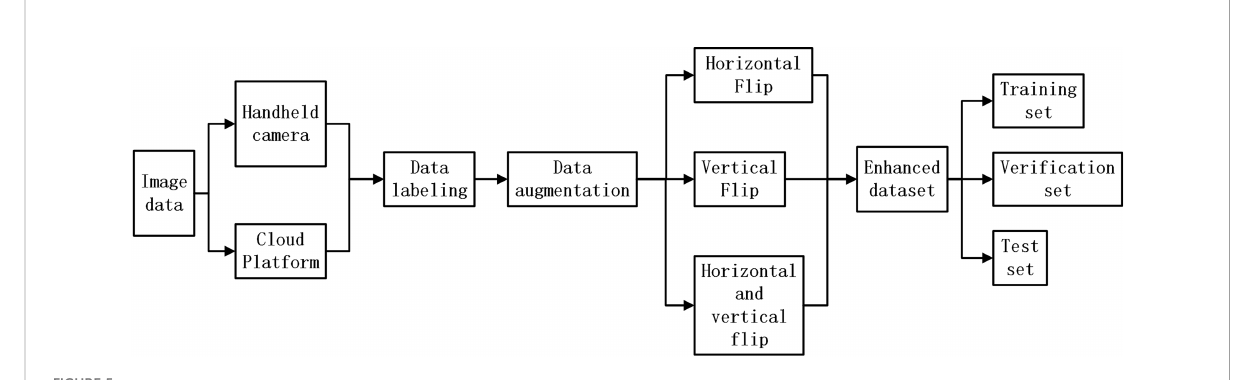
FIGURE 5 Data pre-processing fl ow